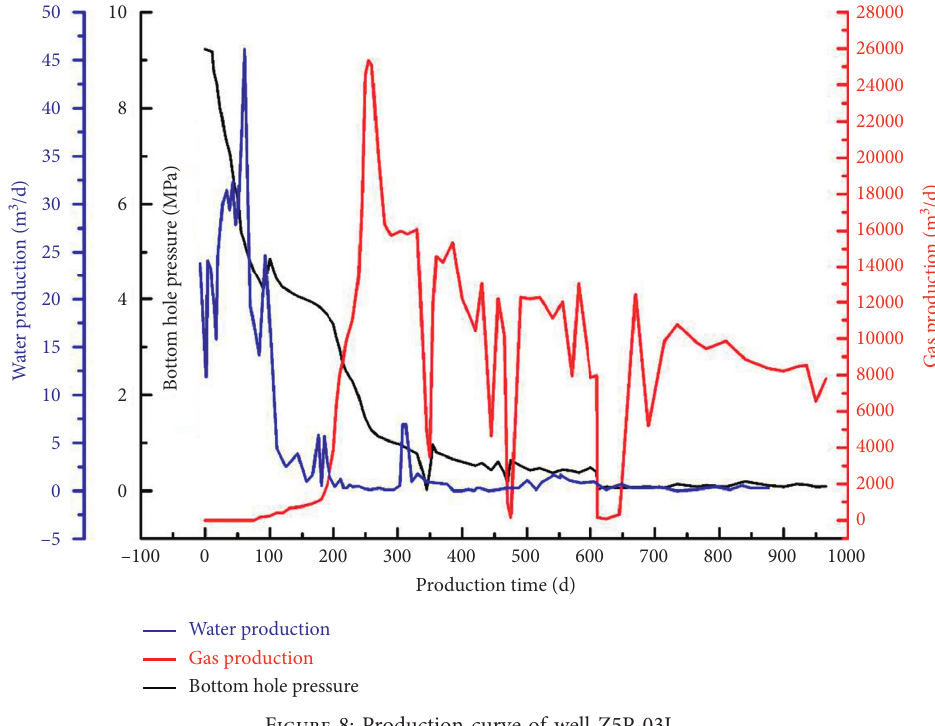
Figure 8: Production curve of well Z5P-03L.